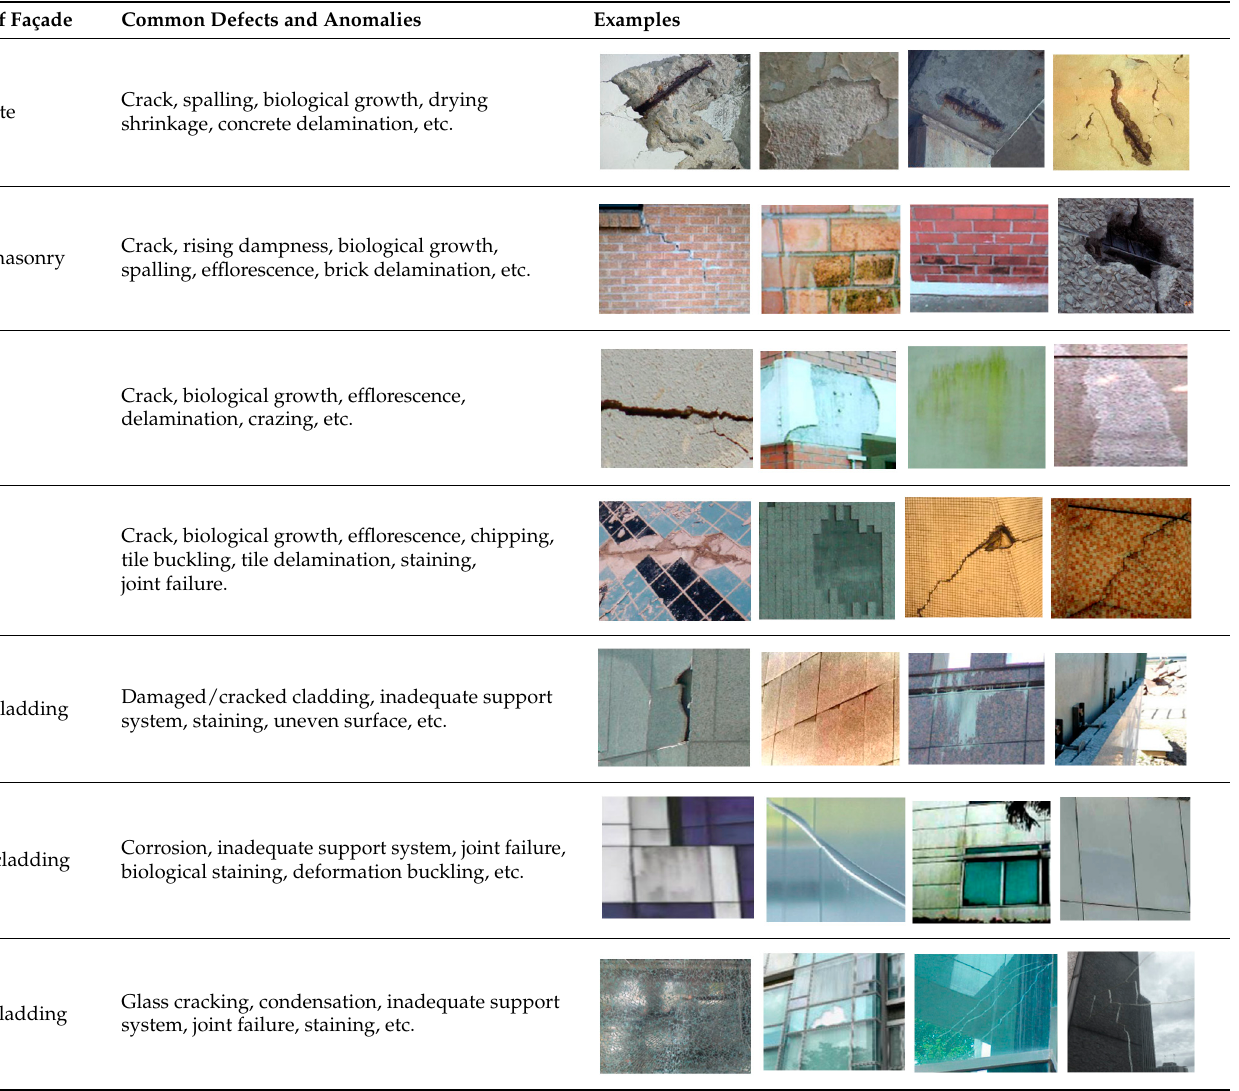
Table 1. Common defects and anomalies from different types of façades.